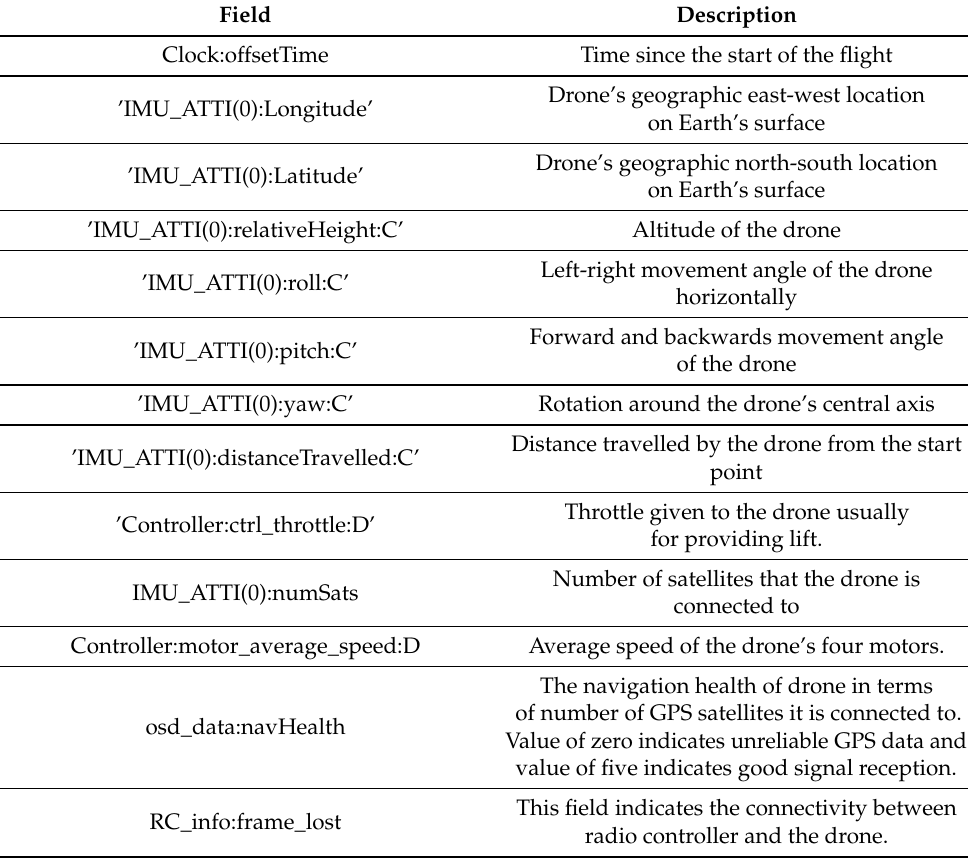
Table 2. Important flight data features for intrusion detection